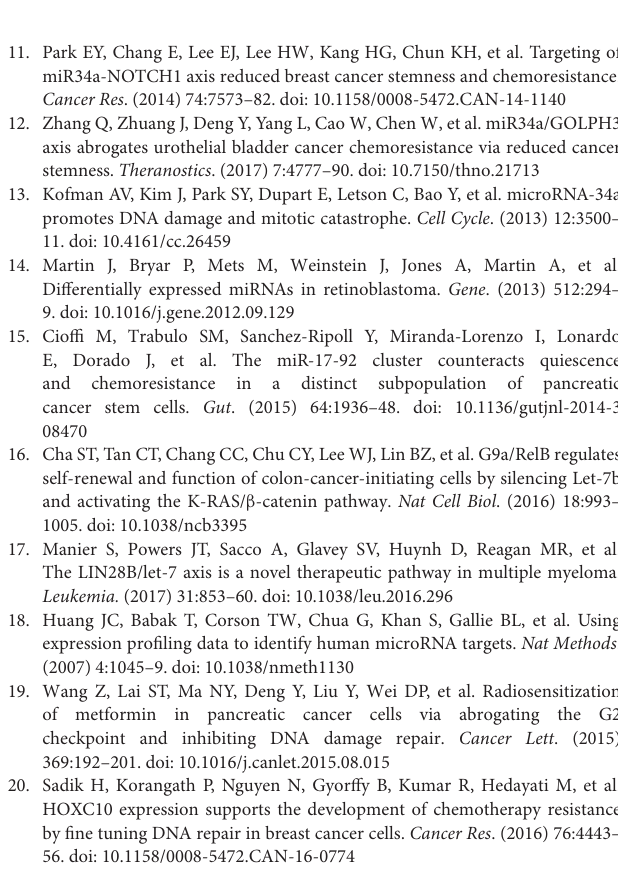
different transfection. Data were presented as mean ± SD of three independent experiments. ∗ P < 0.05, ∗∗ P < 0.01, ∗∗∗ P < 0.0001 vs. negative control group. Figure S2 | (Relates to Figure 3 ) miR-184 increases expression of apoptosis related mRNAs of RB cells in response to ETO treatment. (A) Expression of apoptosis related mRNAs in WERI cells transfected with miR-184 mimic, inhibitor or negative control (NC) were detected by qRT-PCR. (B) WERI cells were transfected with miR-184 mimic, inhibitor or negative control (NC) together with ETO (0.25 µ M) for 48h, expression of apoptosis related mRNAs was detected by qRT-PCR. Data were presented as mean ± SD of three independent experiments. ∗ P < 0.05, ∗∗ P < 0.01, ∗∗∗ P < 0.0001 vs. negative control group. Figure S3 | (Relates to Figures 5 , 6 ) miR-184 inhibits proliferation, migration, and invasion, while enhances apoptosis and G2/M phase arrest of RB cells in response to ETO treatment via inhibiting SLC7A5. (A) Western blot analysis of SLC7A5 expression in Y79 cells and WERI cells transfected with miR-184 mimic alone or together with SLC7A5 expression vector (pcDNA3.1-SLC7A5). (B) Statistical analysis of the EdU-positive cell ratio in WERI cells transfected with miR-184 mimic alone or together with SLC7A5 expression vector (pcDNA3.1-SLC7A5). (C) Statistical analysis of the cell numbers through the transwell chamber in WERI cells transfected with miR-184 mimic alone or together with SLC7A5 expression vector (pcDNA3.1-SLC7A5). (D) WERI cells transfected with miR-184 mimic alone or together with SLC7A5 expression vector (pcDNA3.1-SLC7A5) were treated with ETO (0.25 µ M) for 48h, cellular apoptosis was detected by flowcytometry and the Annexin V + PI + -positive cell ratio were presented. (E) 48h after transfected with miR-184 mimic alone or together with SLC7A5 expression vector (pcDNA3.1-SLC7A5), Y79 cells were treated with ETO (0.25 µ M) for different time and the ratio of Y79 cells in G2/M phase in each time point were presented. Data were presented as mean ± SD of three independent experiments. ∗∗ P < 0.01, ∗∗∗ P < 0.0001 vs. negative control